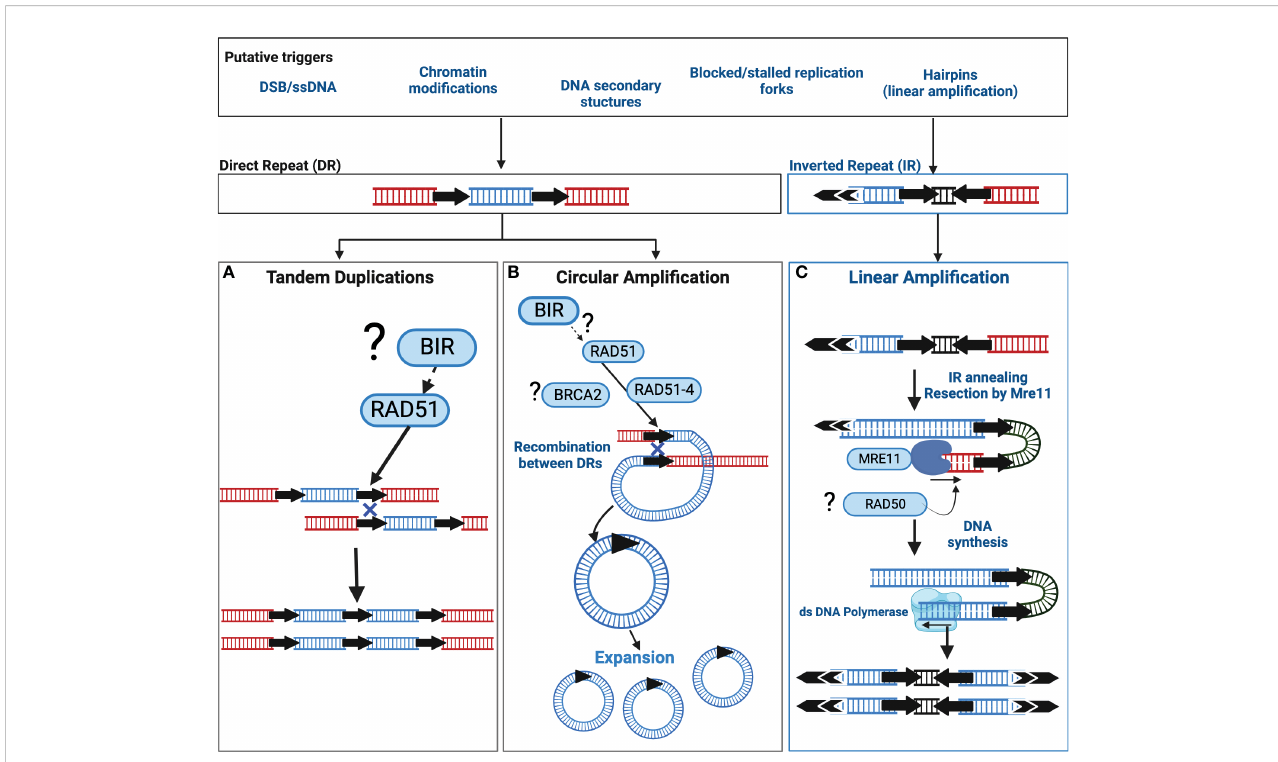
FIGURE 1 Putative models of extrachromosomal ampli fi cation in Leishmania driven by DNA Repeats. In Leishmania , extrachromosomal DNA ampli fi cation can be catalysed by either Direct Repeats (DRs) or Inverted Repeats (IR). Though the precise trigger(s) are unknown, putative sources of DNA instability are listed in the corresponding box above that may contribute to DNA ampli fi cation in Leishmania . Recombination reactions associated with DRs can result in tandem duplications and circular amplicons. The recombinase RAD51 facilitates a homology driven recombination between DRs that may result in (A) a tandem duplication, or (B) extrachromosomal circular amplicons. The mechanism driving tandem duplication events is unclear and may be the result of Break Induced Replication (BIR) or form an uneven exchange of genetic information between sister chromatids. Black arrows = DRs, (?) = the involvement of this factor or pathway requires experimental con fi rmation, Blue Cross indicates homologous recombination. (C) Linear ampli fi cation is driven through an annealing reaction between IRs. Here, the exonuclease activity of Mre11 may process a DNA lesion, for example a single strand break, or a hairpin structure formed due to DNA replication, after which the IRs anneal, and the DNA is replicated. Double arrows = telomeric sequences. Black arrows = IRs. Diagram adapted from (Laf fi tte et al.,